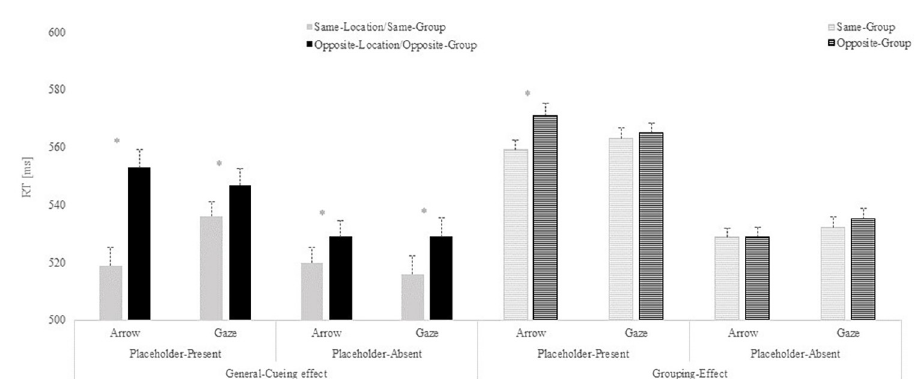
Fig 6. Reaction times (RTs) results from Experiment 2. Results are shown separately for the general-cueing effect and the grouping-effect. Mean RTs presented for each type of cue as a function of the cue-target relation in the placeholder-present and placeholder-absent conditions. Error bars represent the standard error of the mean, computed following Cousineau’s [31] method to eliminate variability between